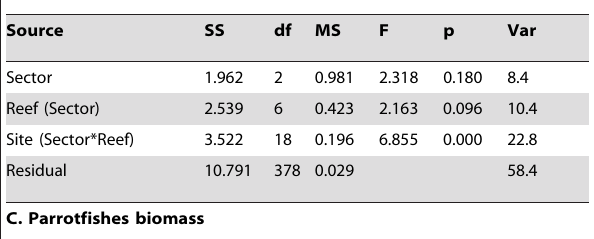
Table 2. Multivariate analyses of variance to test for variation in taxonomic composition of (A) juvenile corals, and (B) adult corals among latitudes, reefs, and